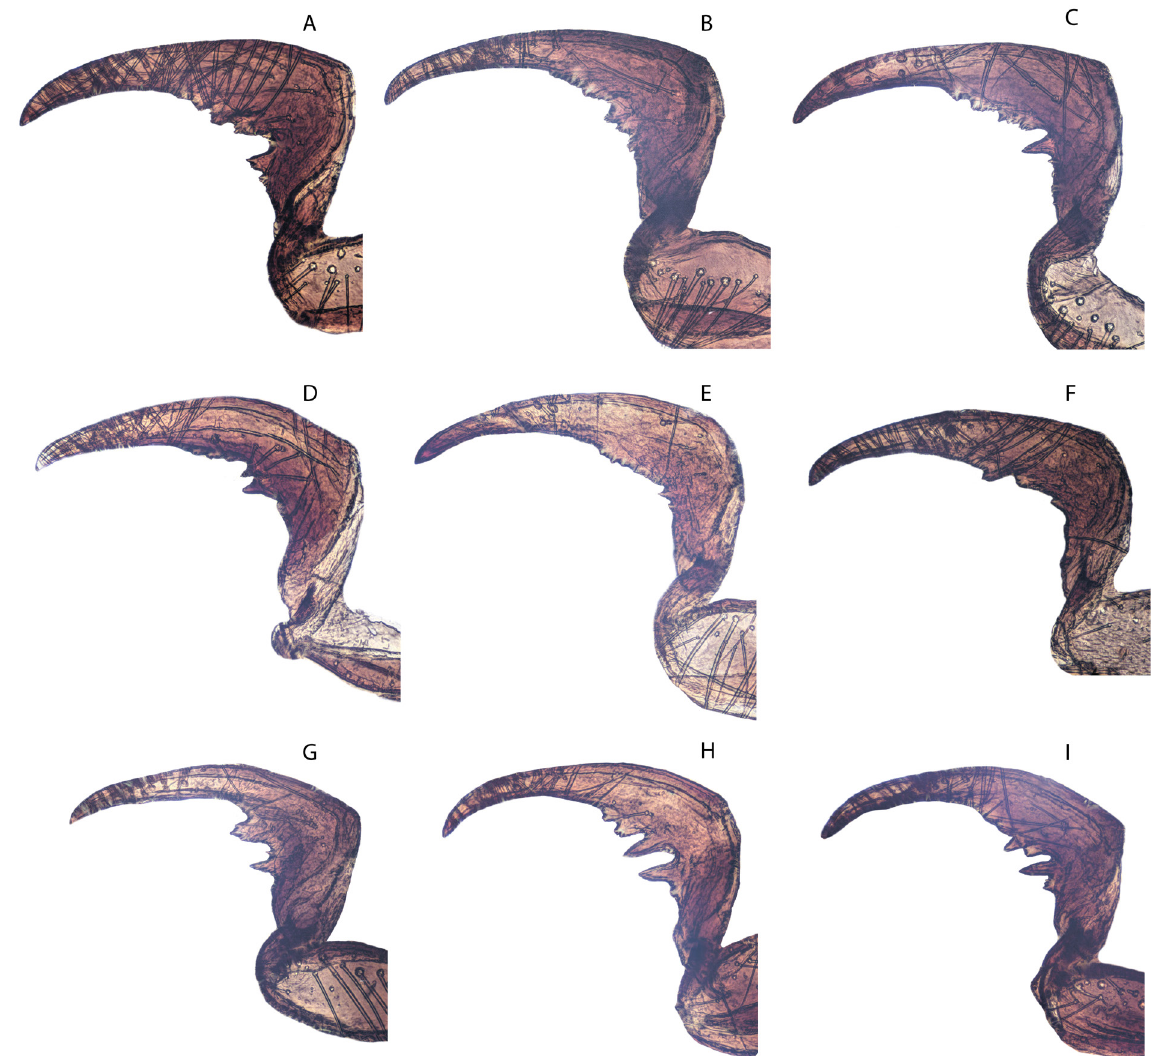
Fig. 19. Male genitalia and harpe. A–C . Melitaea timandra timandra Coutsis & van Oorschot,